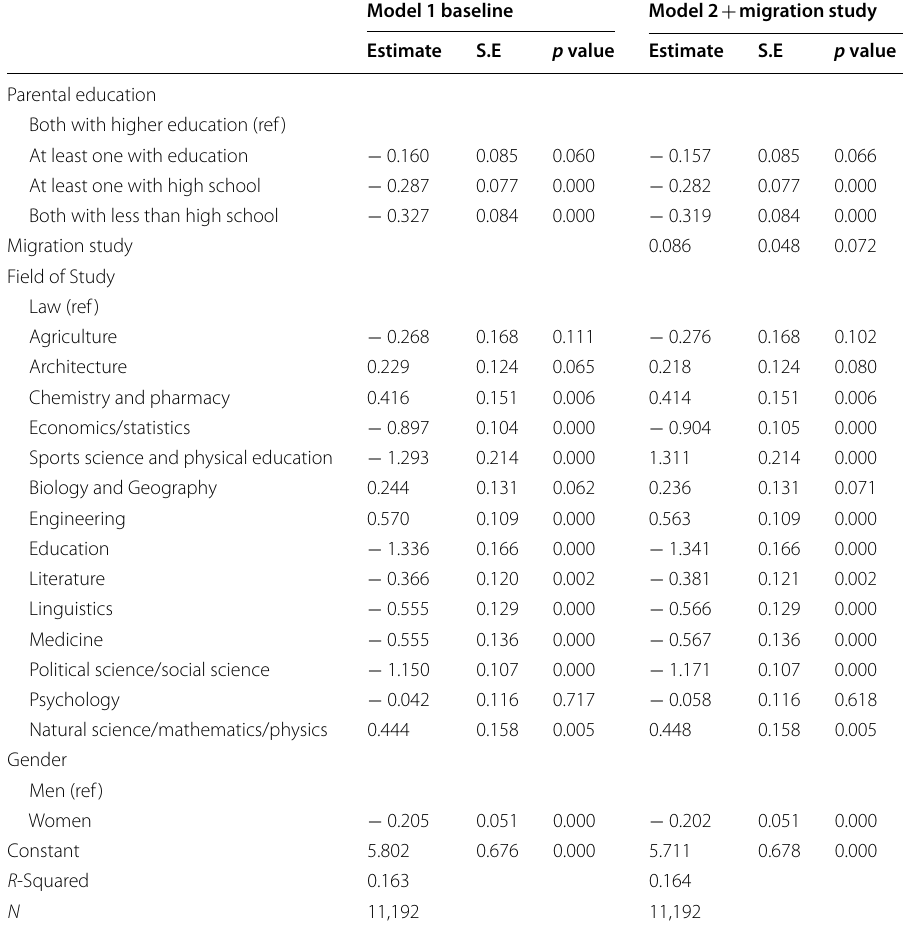
Table 4 Predicting graduates’ access to professional and managerial occupations 5 years after